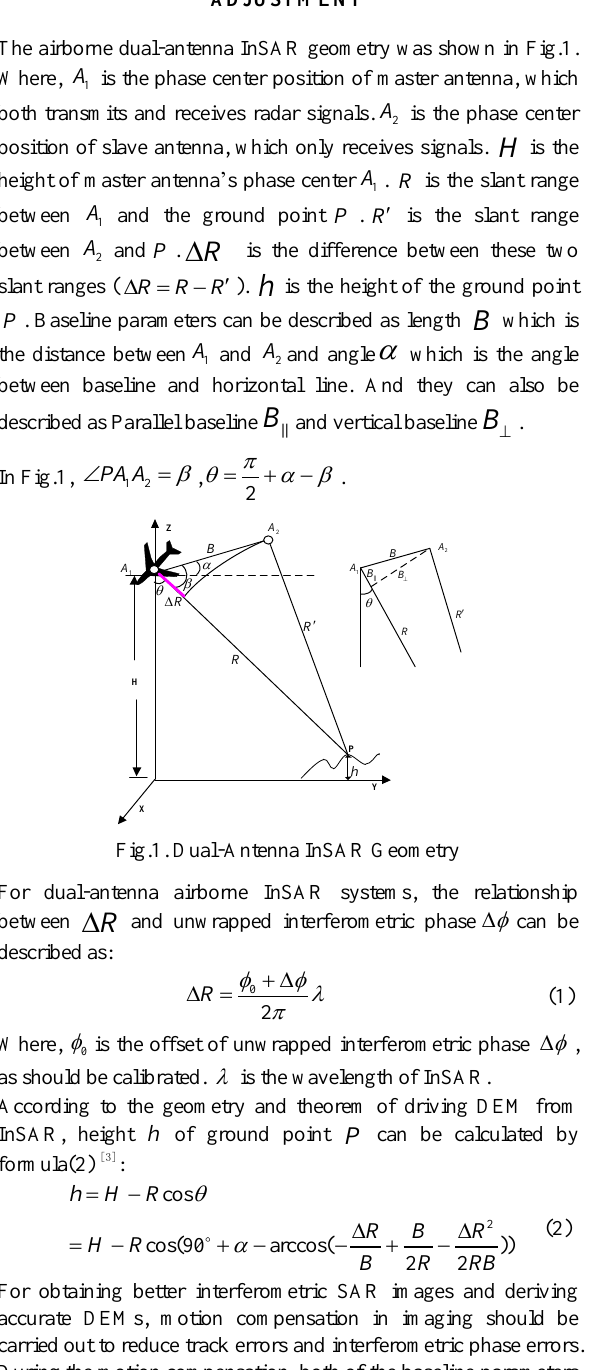
Fig.3. Number of needed GCPs (at least) for each block Because formula (5) is a nonlinear equation about B ,  and it should be linearized. In order to deduce the linearization clearly, formula (5) is described briefly as: The linearized formula is list as